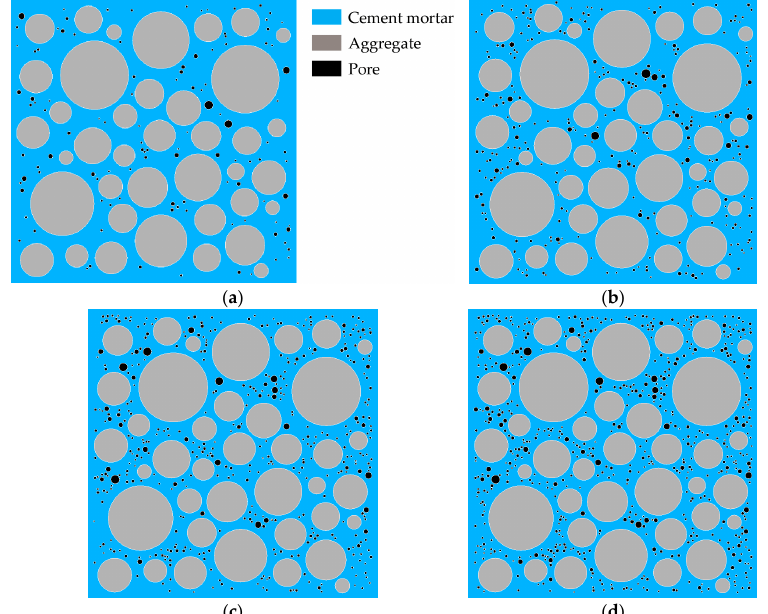
Figure 1. Some specimens with the same aggregate structure and total porosity of 1%, 2%, 3%, and 4%. ( a ) 1-1-X (total porosity = 1%); ( b ) 2-1-X (total porosity = 2%); ( c ) 3-1-X (total porosity = 3%); ( d ) 4-1-X (total porosity = 4%).